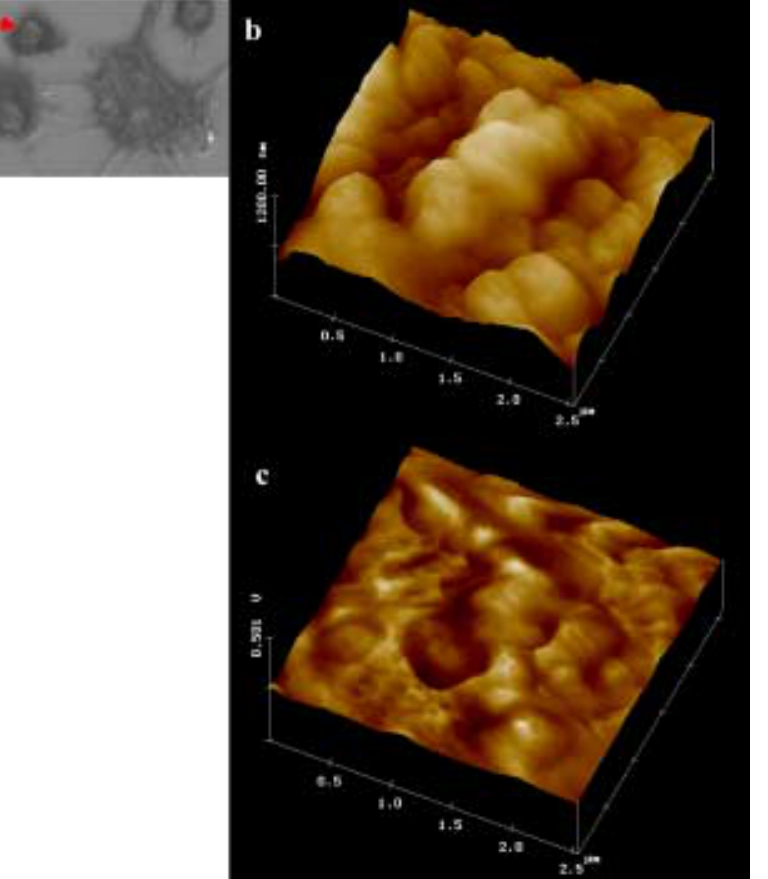
Fig. 3. (a) Far-field image of cells of the breast cancer cell line T-47D (after 48 hours treatment with 5 × 10 − 9 M E 2 ) detected with 40 × magnification; typical globular shape is visible. (b) Near-field topographic image of a cellular surface section of the breast cancer cell indicated in (a) by an arrow; typical rosettes separated by furrows are visible; (c) near-field transmission light image of the same surface section. Regions of the rosettes do not always correspond to low absorbance